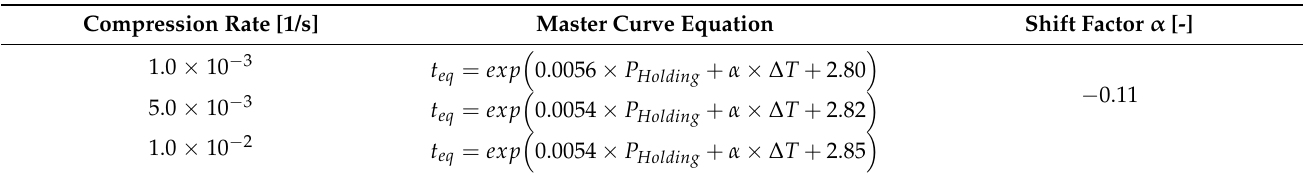
Table 3. Derived master curves to calculate the pressure and temperature dependent equilibrium time of the COC for all investigated compression